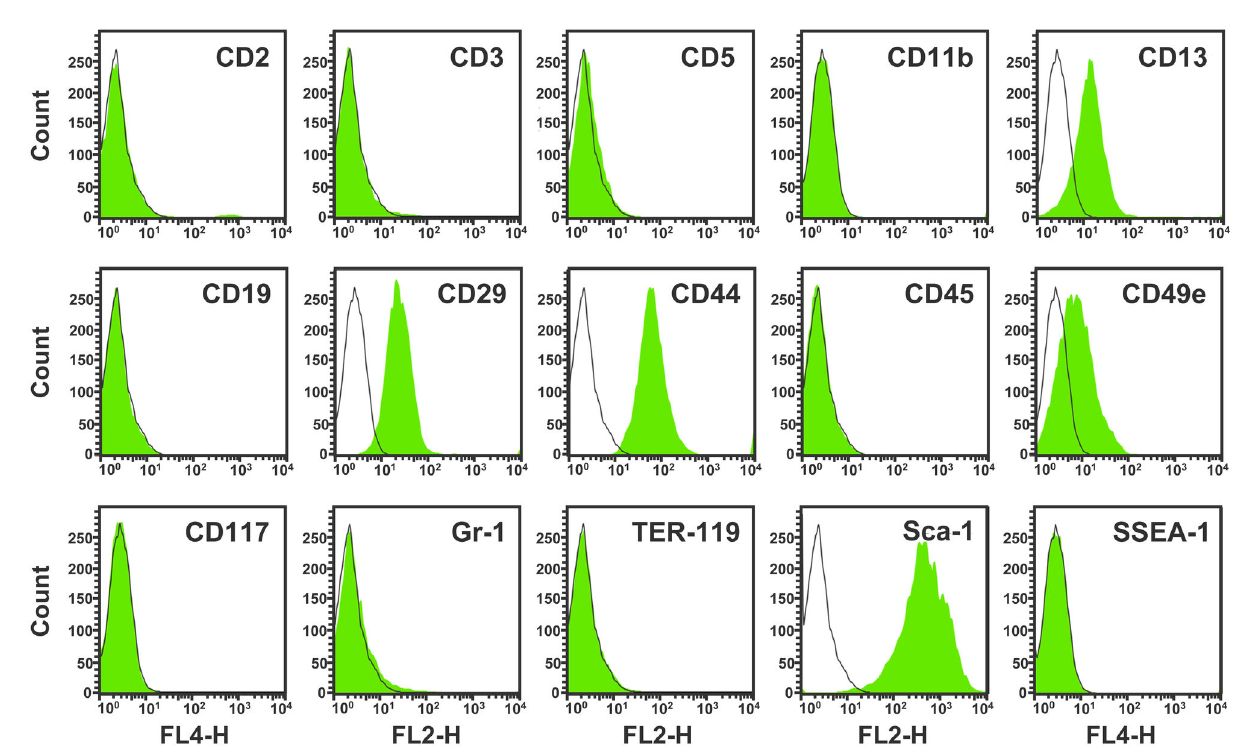
Figure 2. Immunophenotype antigen profile of mUC-MSCs. Cells of passage number 12–20 were labeled with PE- or APC- conjugated antibodies against the indicated antigens, and analyzed by flow cytometry. Hematopoietic cells markers, including CD2, CD3, CD5, CD11b, CD19, CD45, CD117, Gr-1, and TER-119; mesenchymal stem cells markers, including CD13, CD29, CD44, CD49e, and Sca-1; and mES cells marker, SSEA-1, were used. The respective isotype control was displayed as an open histogram (dark gray line), and specific antibody was displayed as a filled histogram (green). doi: